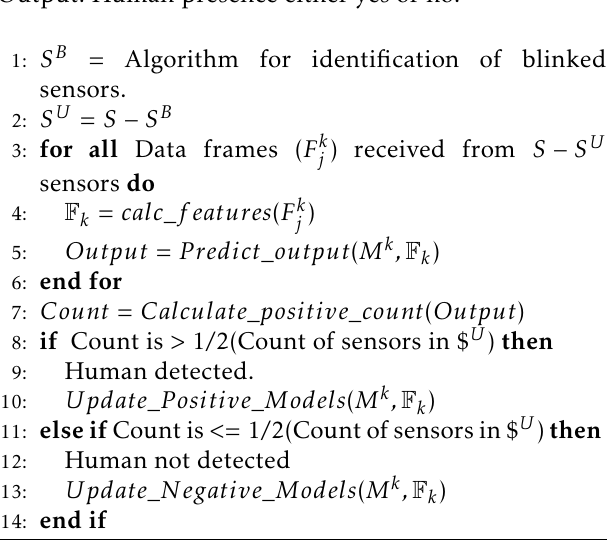
Algorithm 2 Algorithm for detection of